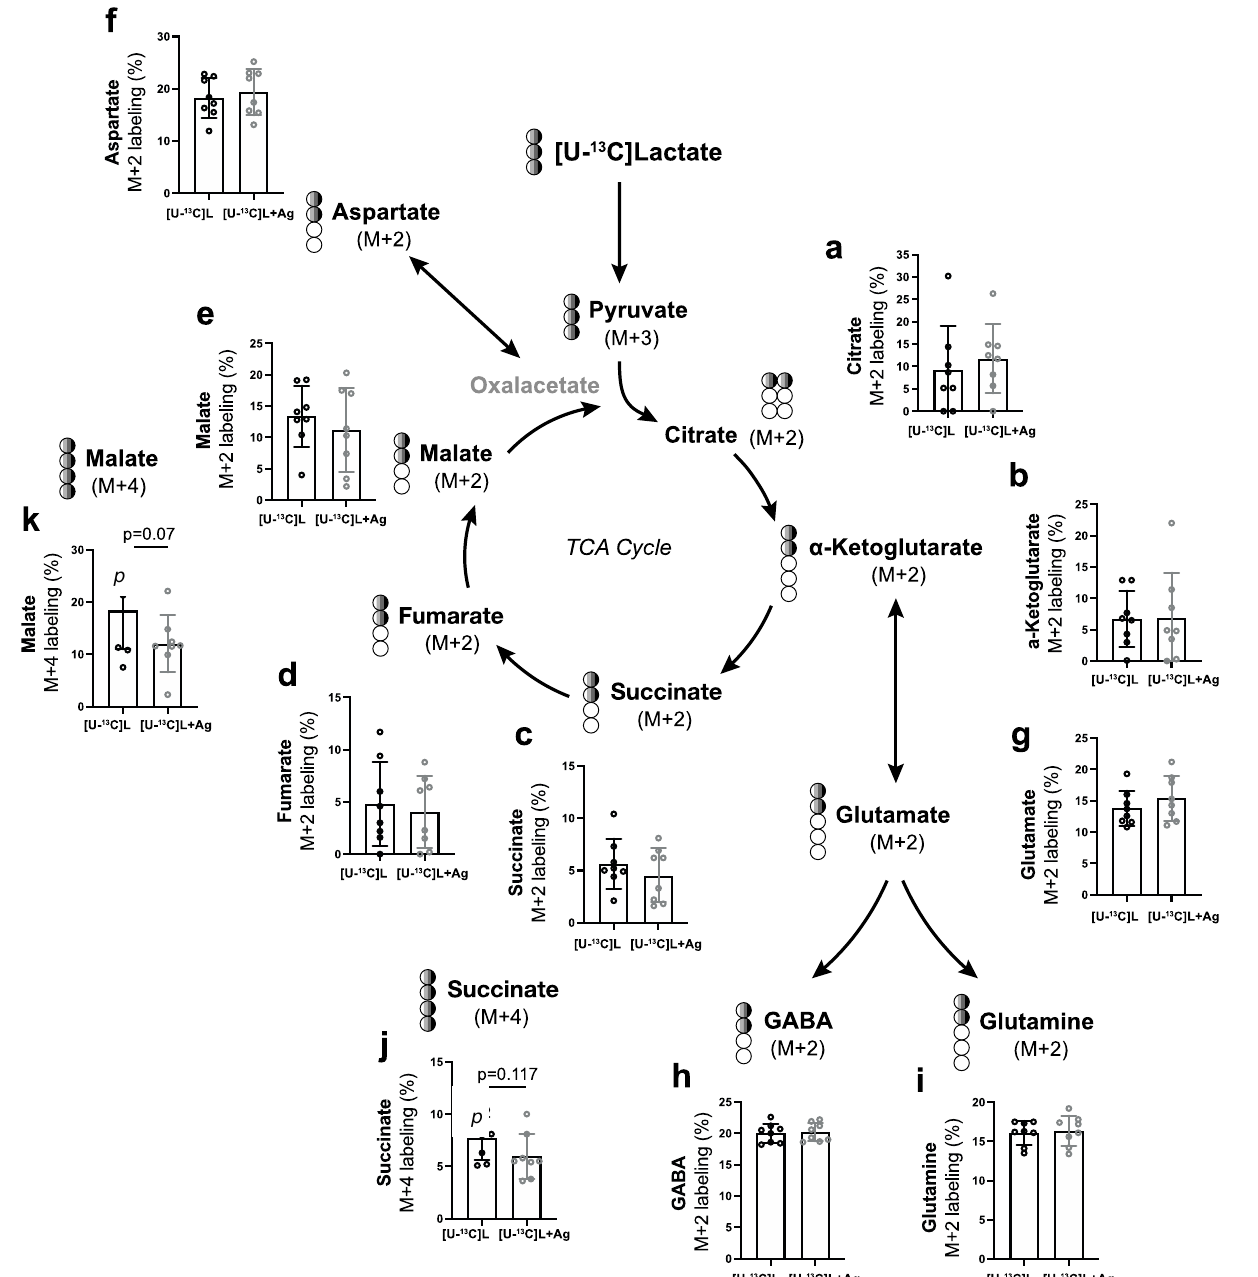
Figure 6. Retinal metabolism of [U- 13 C]lactate in response to 3,5-DHBA (Ag) treatment. ( a – k ): Retinal explants were incubated for 2 hours with 10 mM [U- 13 C]lactate in the absence or presence of 5 mM of 3,5-DHBA. No significant changes in the relative abundance of 13 C labeling were found in any of the measured metabolites. However, tendencies towards a decrease in malate (M+4) and succinate (M+4) were observed. Values are presented as mean ± S.D. (n = 8 retinal quarters originating from eight different whole retinas). Statistics: Unpaired t-test.